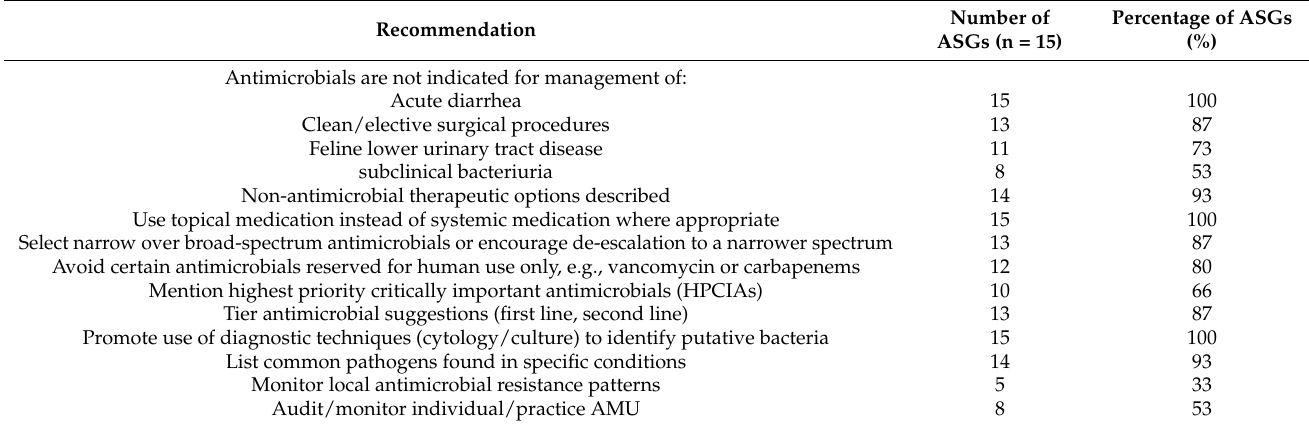
Table 2. Frequency of recommendations in